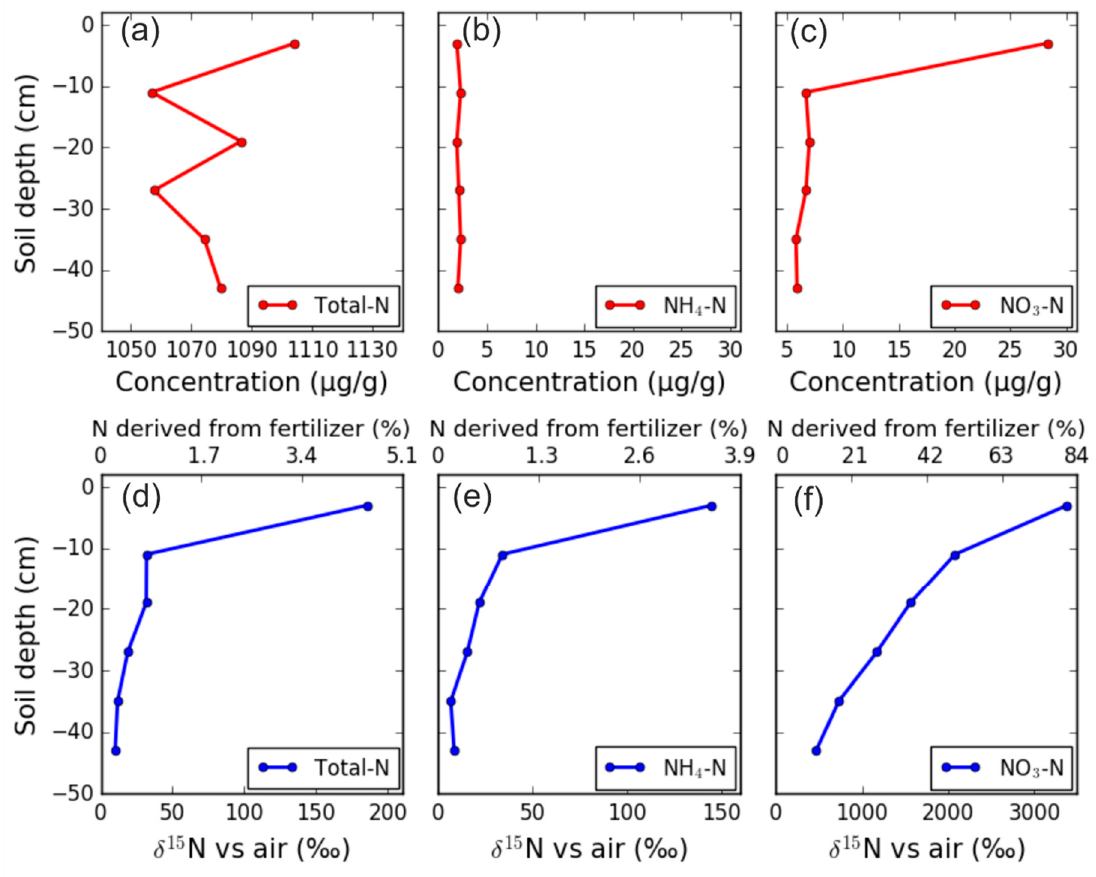
Figure 10. Concentration of ( a ) total N, ( b ) ammonium (NH 4 + ), and ( c ) nitrate (NO 3 − ) in soil, and δ 15 N of ( d ) total N, ( e ) NH 4 + and ( f ) NO 3 − at the end of the series of experiments.